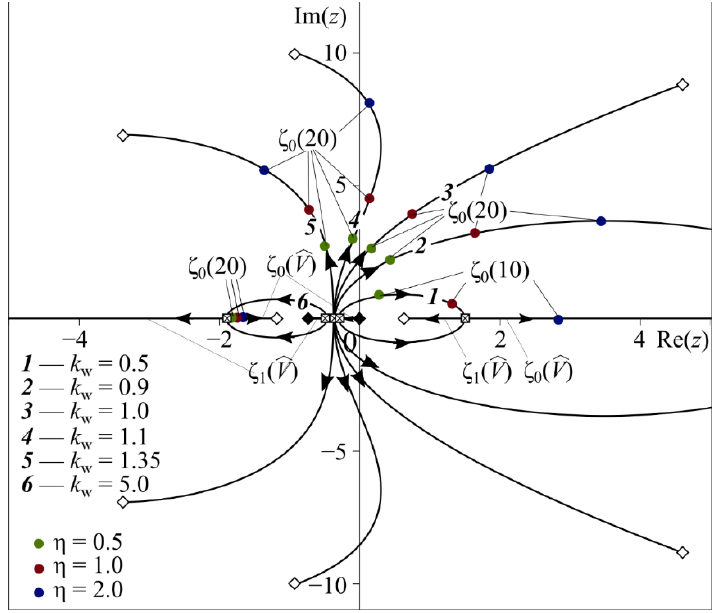
Figure 2. Movement of zeros of R ( z ) (47) in the complex plane when ˆ V changes from 0 to ∞